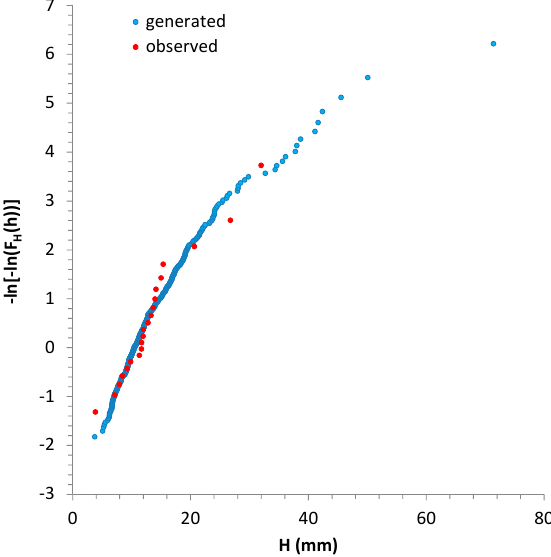
Figure 2 . EV1 probability plot of 20-min annual maxima H at basin scale: comparison between observed (estimated by using the technique of Voronoi polygons) and generated series for Corace at Grascio.